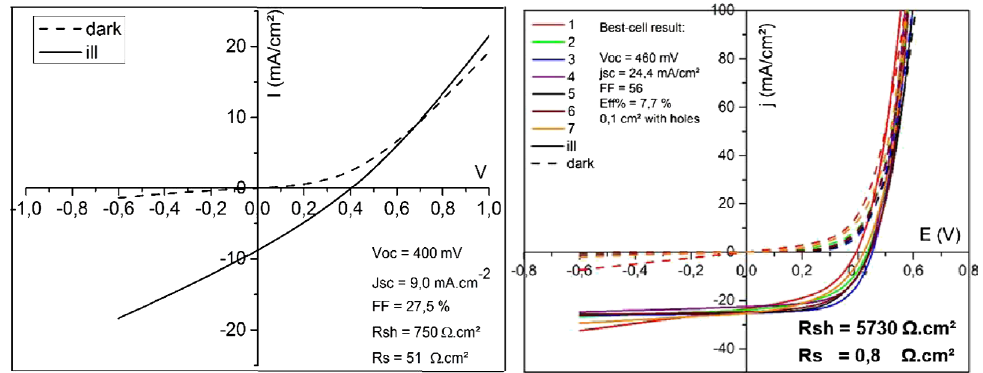
Fig. 7. (a) I-V curves on complete device; (b) localized I-V curves on 0.1cm 2 surfaces